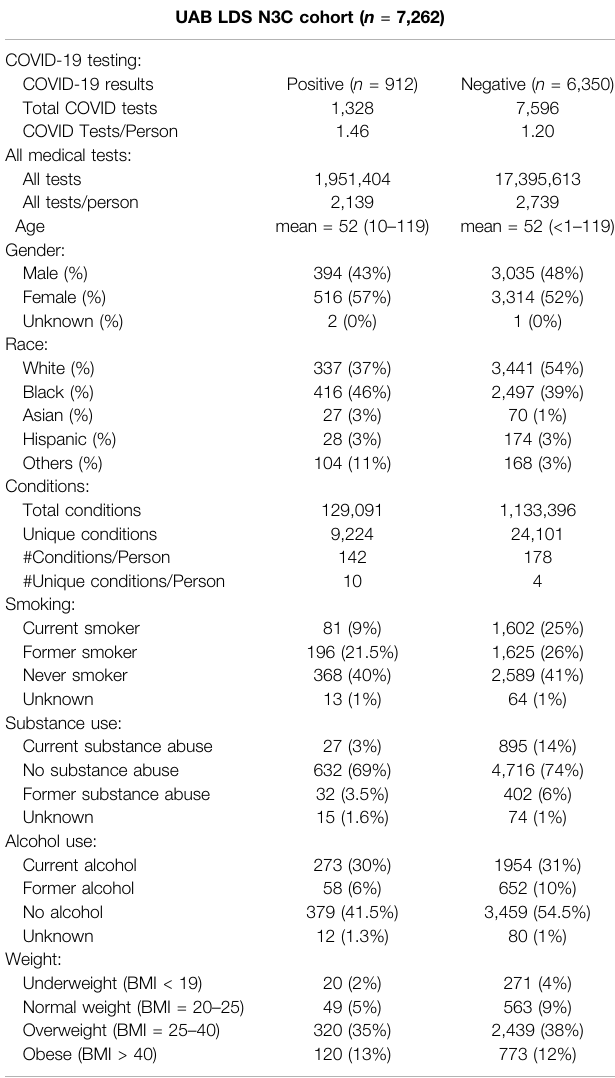
TABLE 1 | Demographics and Clinical Characteristics of the UAB LDS N3C